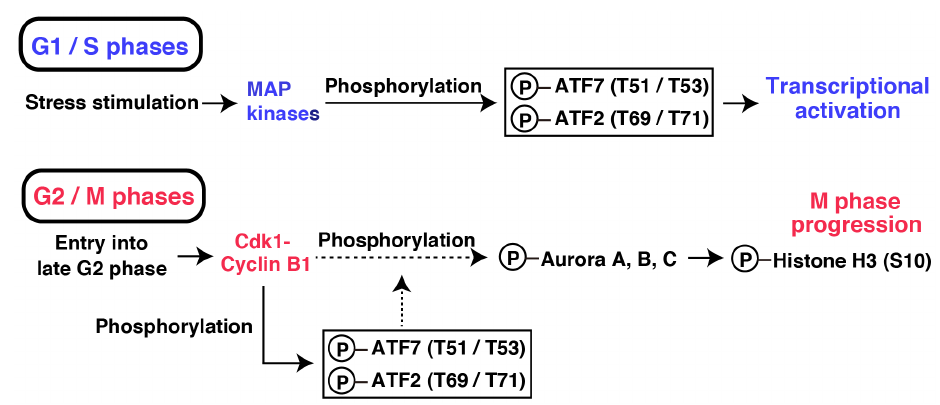
Fig. 7. Differential roles for the phosphorylation of ATF7 and ATF2 in G1/S phases and G2/M phases. In G1 and S phases, ATF7 and ATF2 are phosphorylated at Thr-51 and Thr-53 and at Thr-69 and Thr-71, respectively, by stress-activated MAP kinases, to induce their transcriptional functions. During late G2 and M phases, the Thr-51/Thr-53 on ATF7 and the Thr-69/Thr-71 on ATF2 are phosphorylated by Cdk1-cyclin B1, which promotes M-phase entry via the stabilization of Aurora